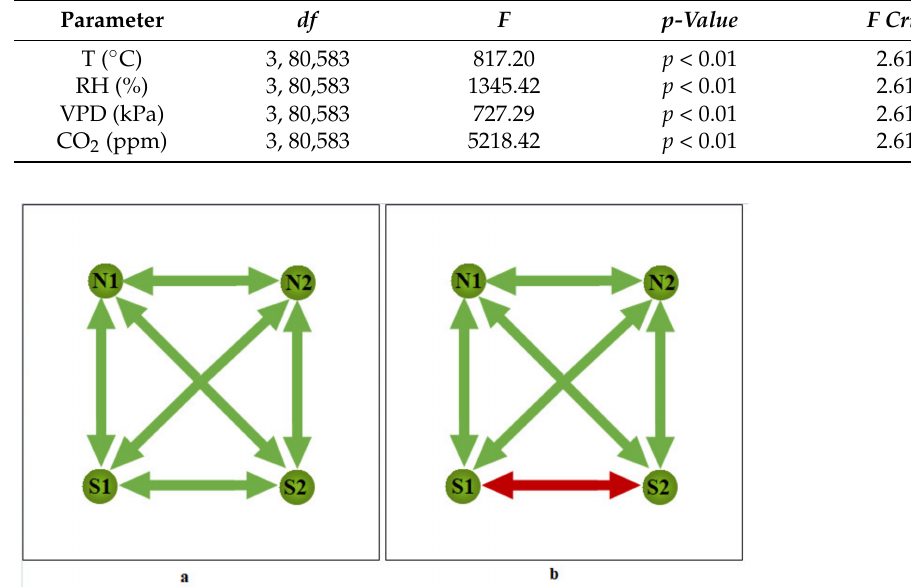
Figure 8. The Tukey pairwise comparison of all sensors for ( a ) T and CO 2 ( b ) RH and VPD, in MSG. (Significant, Nonsignificant @ p <